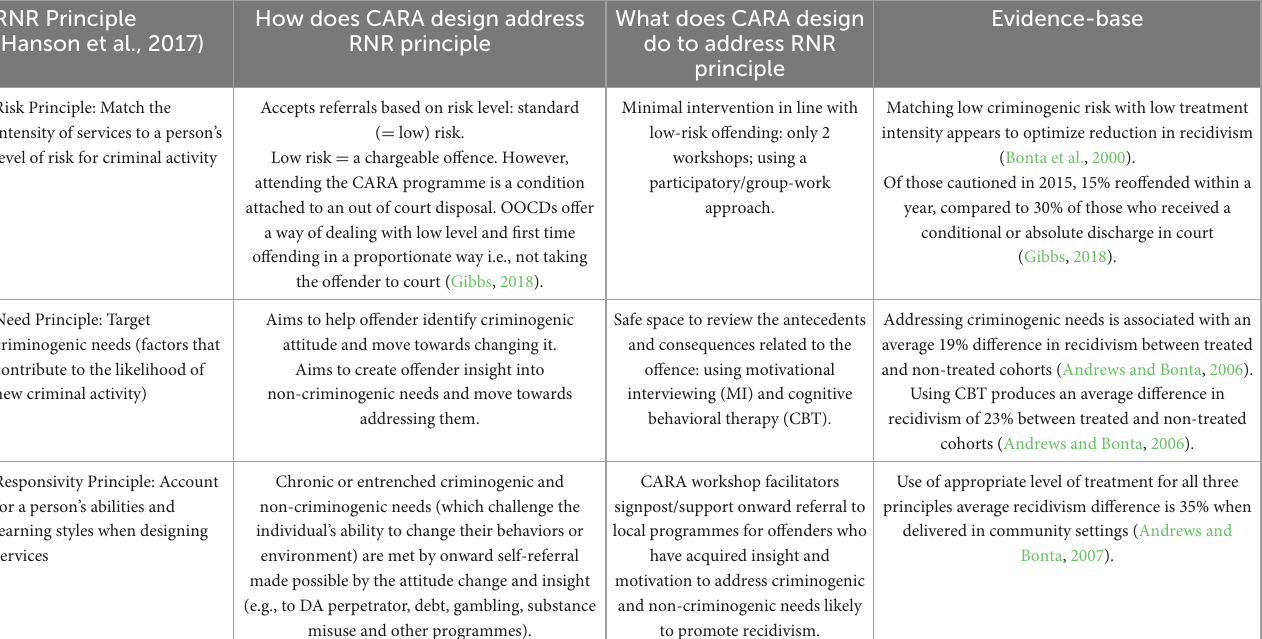
TABLE 1 RNR principles vis-a-vis CARA.